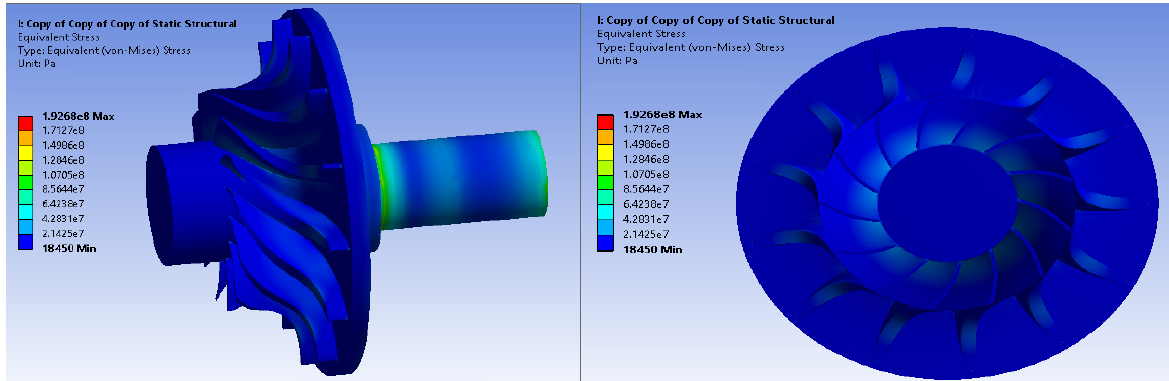
Figure 18. Equivalent Von Misses stress